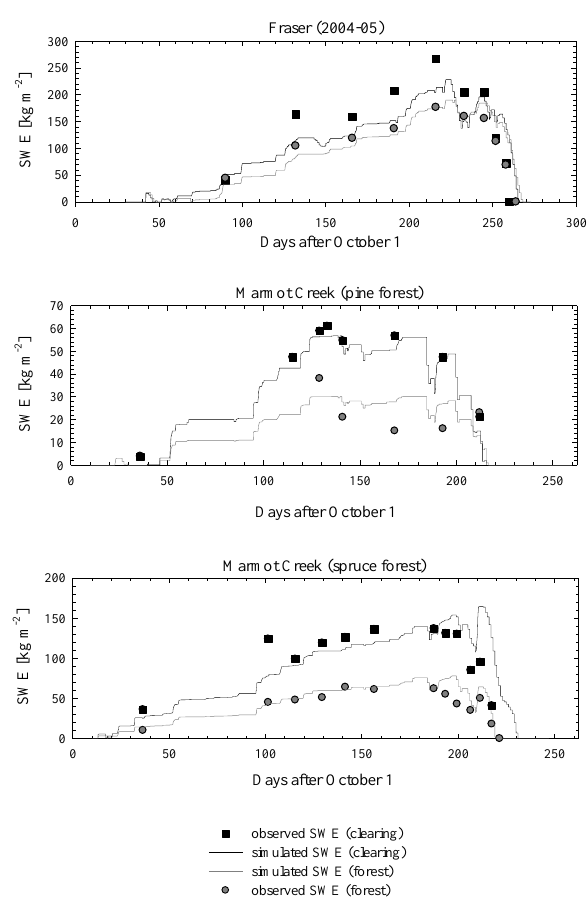
Figure 4. Fig. 4. Continued.